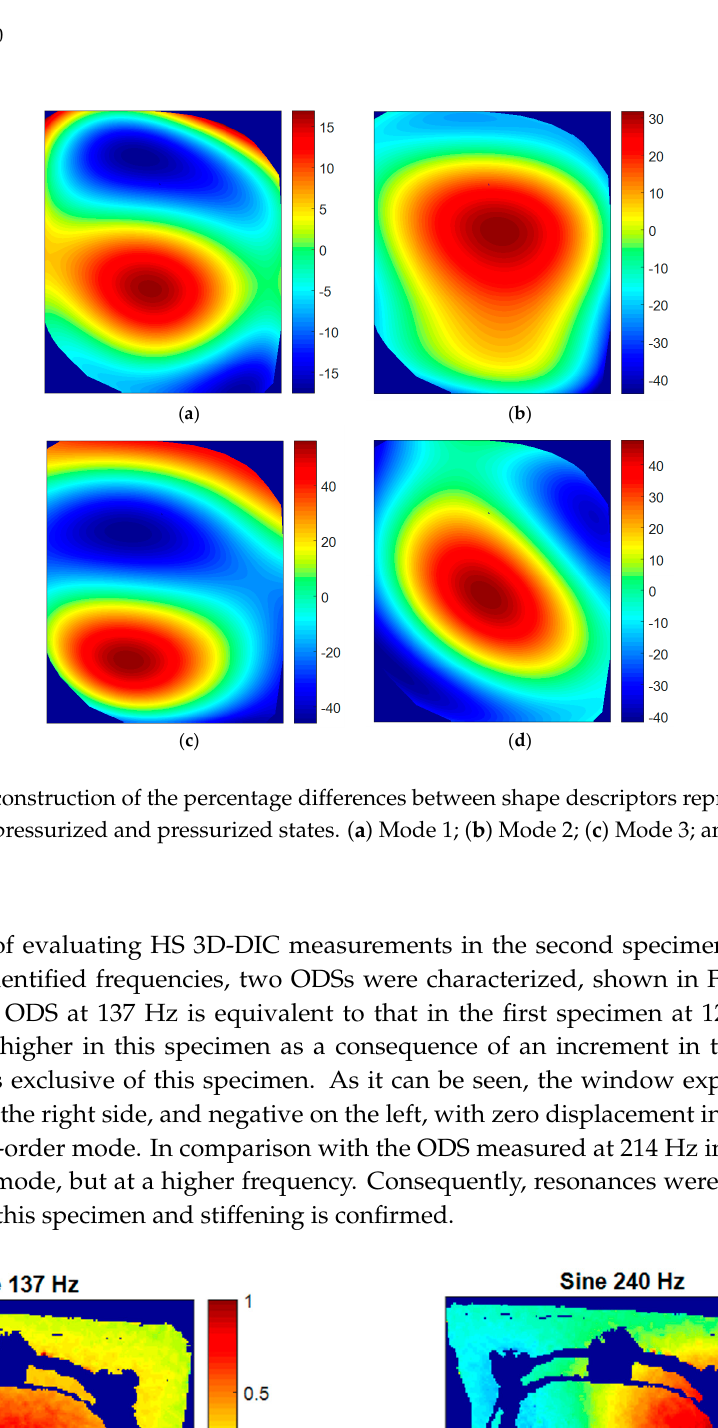
Figure 16. Normalized ODSs in the out-of-plane direction obtained using HS 3D-DIC in a random excitation test under differential pressure.